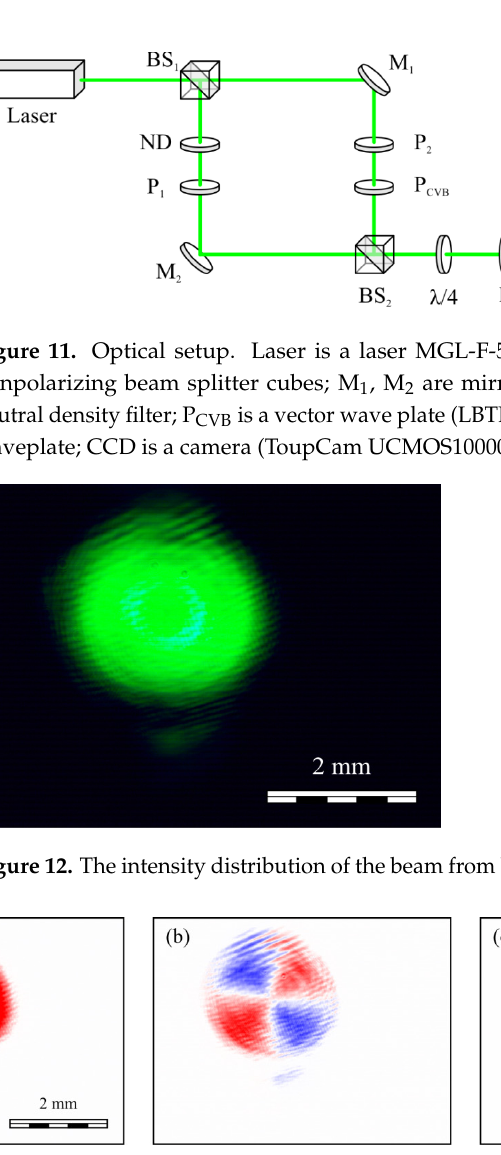
Figure 13. Measured components of the Stokes vector: s1 ( a ), s2 ( b ) and s3 ( c ). Blue and red colors denote the negative and positive values, respectively.